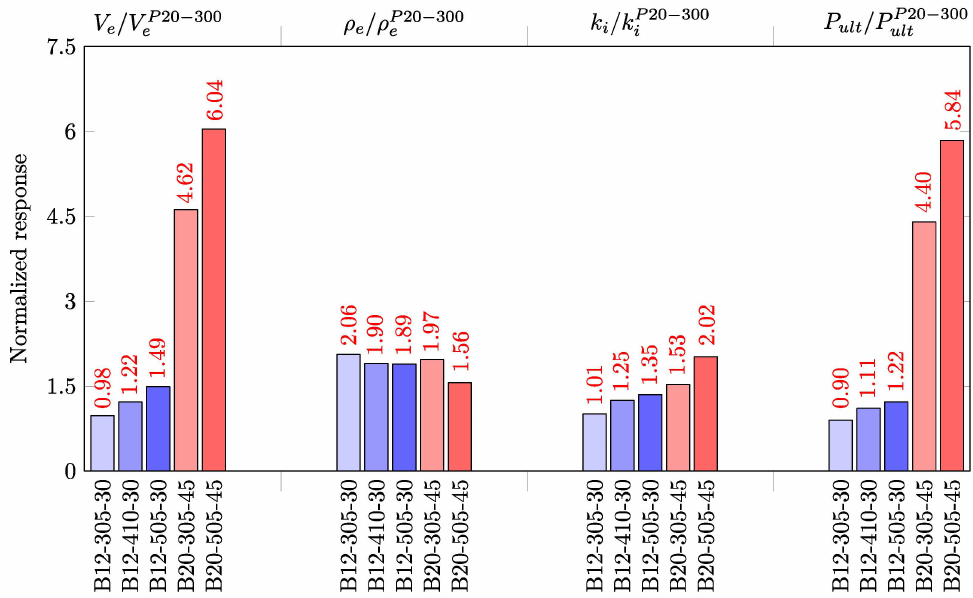
Figure 10. Shear response of CWSGs with regard to web depth